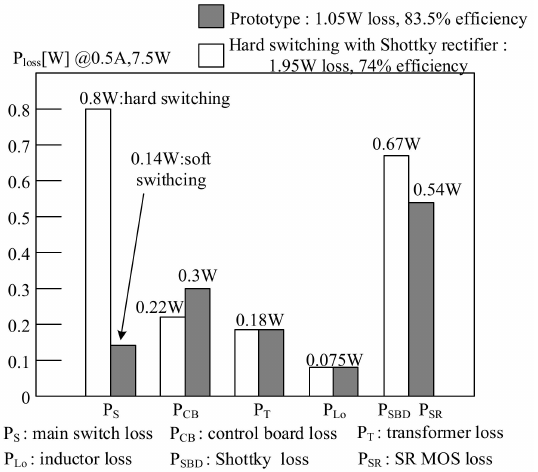
Figure 8. Estimated power loss comparison between the prototype and the traditional forward converter at 0.5 A load and 28 V